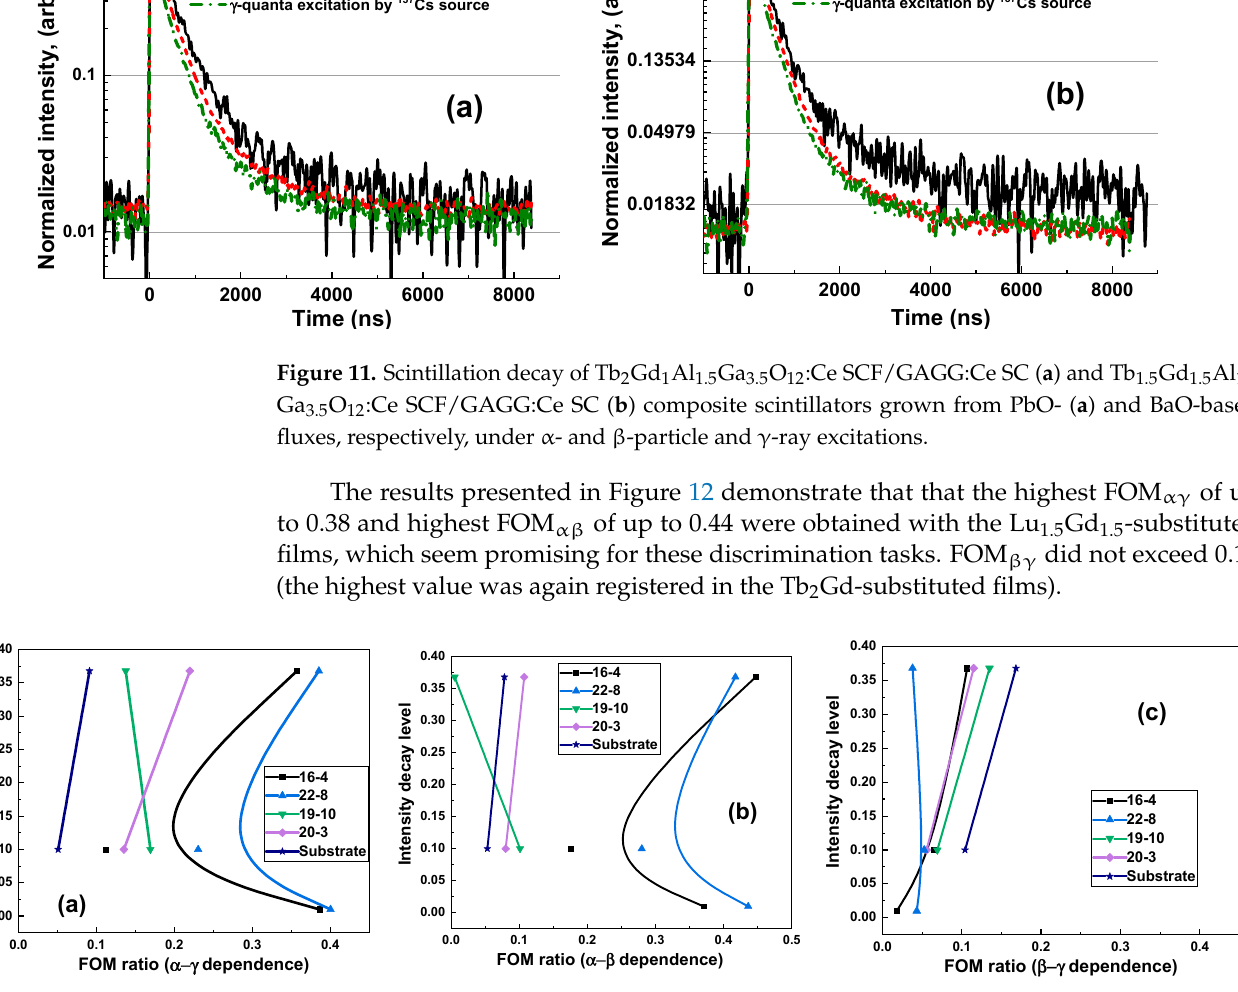
Figure 12. Figures of merit for the different pairs of irradiation types, FOM αγ ( a ), FOM a β ( b ), and FOM βγ ( c ) of the selected composite scintillators under study.